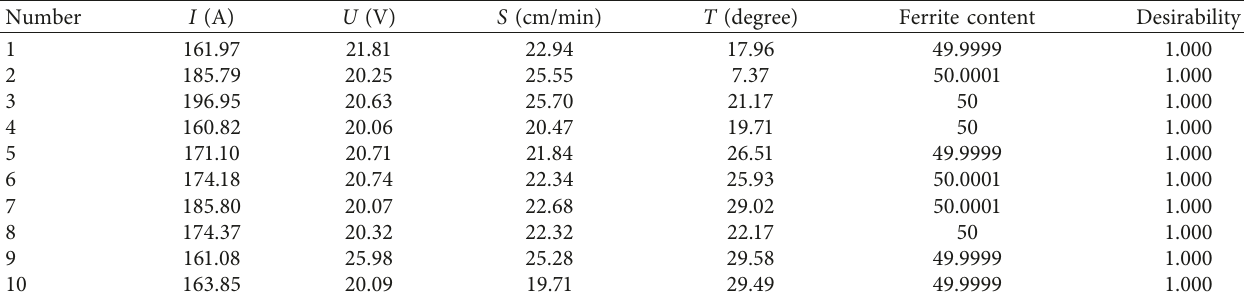
Table 6: Desirable